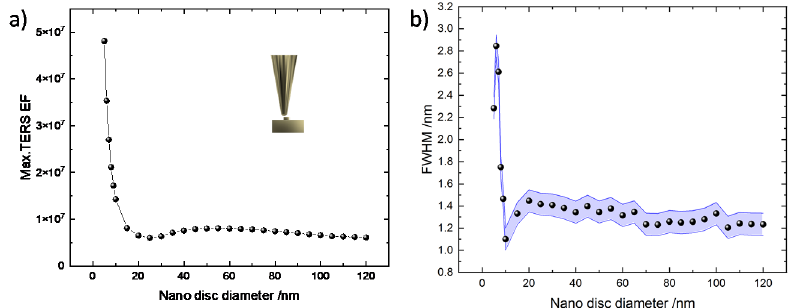
Figure 4. Simulation of TERS EF when the tip is placed at the edge of a nanodisc. ( a ) Maximum TERS EF and ( b ) FWHM of the TERS intensity. The geometry is presented in the inset of Figure 4a. The blue shaded area presents the error bar of the FWHM in Figure 4b.